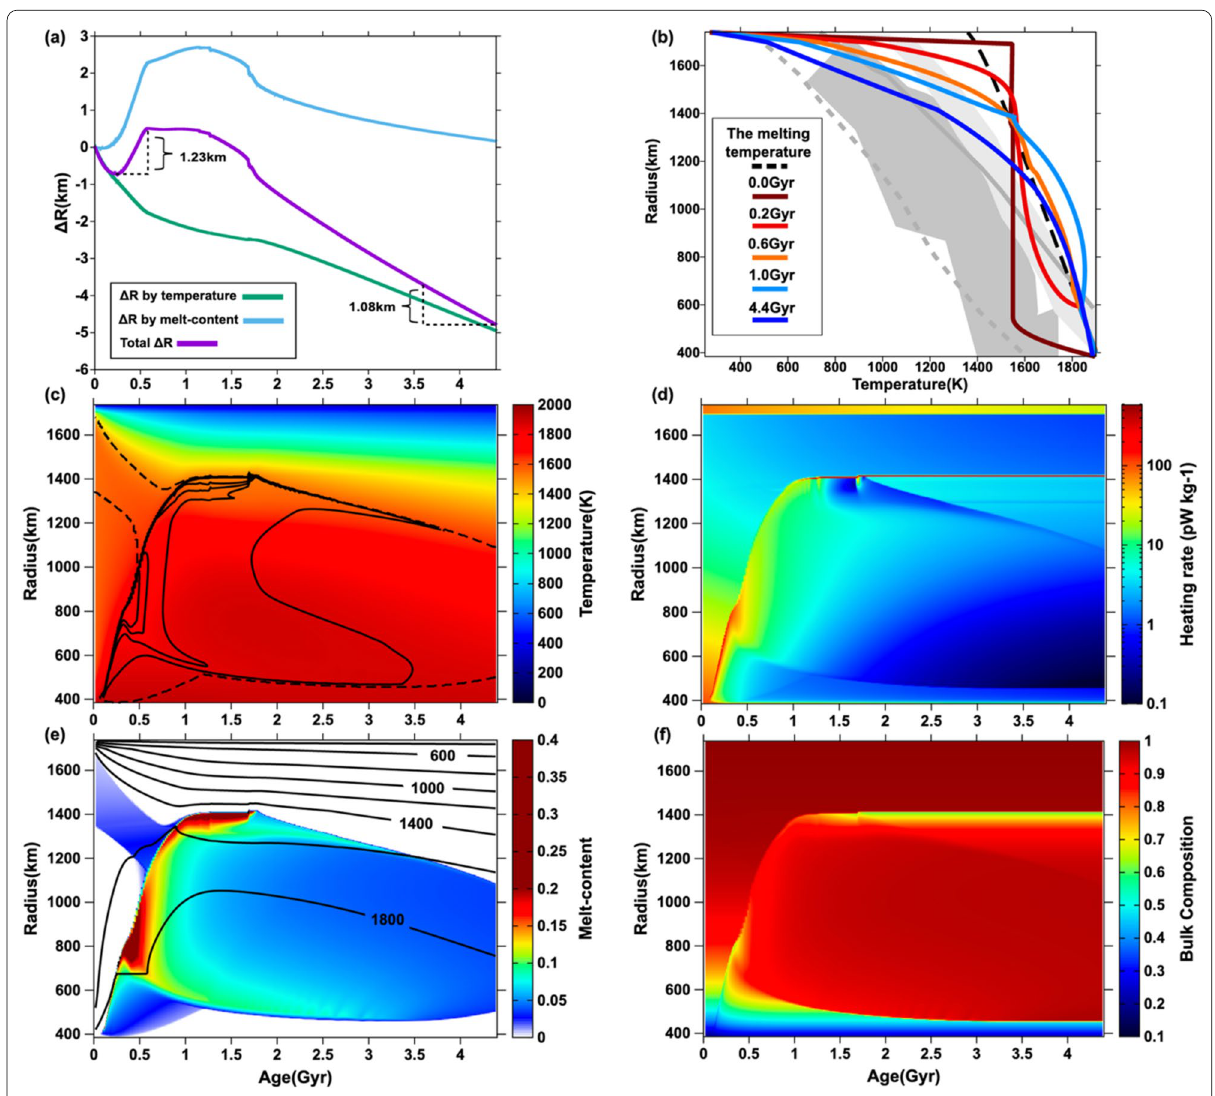
Fig. 2 The reference model. a The plot of radius changes against time, b temperature profile as a function of time, and the evolution of the distribution of c temperature, d internal heating rate, e melt-content, and f bulk composition ξ b . The assumed parameter values are T M = 1550K, M ∗ = 28, F ∗ 8, L ∗ = 1 / 5.5 . In a the green and light blue lines indicate the contribution of thermal expansion and melting, crst = respectively, to the total radius change (the purple line). In b the gray and light-gray areas are the temperature distributions in today’s lunar mantle inferred by Khan et al. (2006) and Khan et al. (2014), respectively; the gray lines are those estimated by Karato (2013) under the assumption that the mantle consists of dry olivine (the solid line) and that containing or wet olivine with the H 2 O-content of 100 ppm (the dash line). In c , the contour lines show the distribution of melt-content with the contour interval of 0.05 starting from 0 (indicated by the dashed line); in e the contour lines show the distribution of